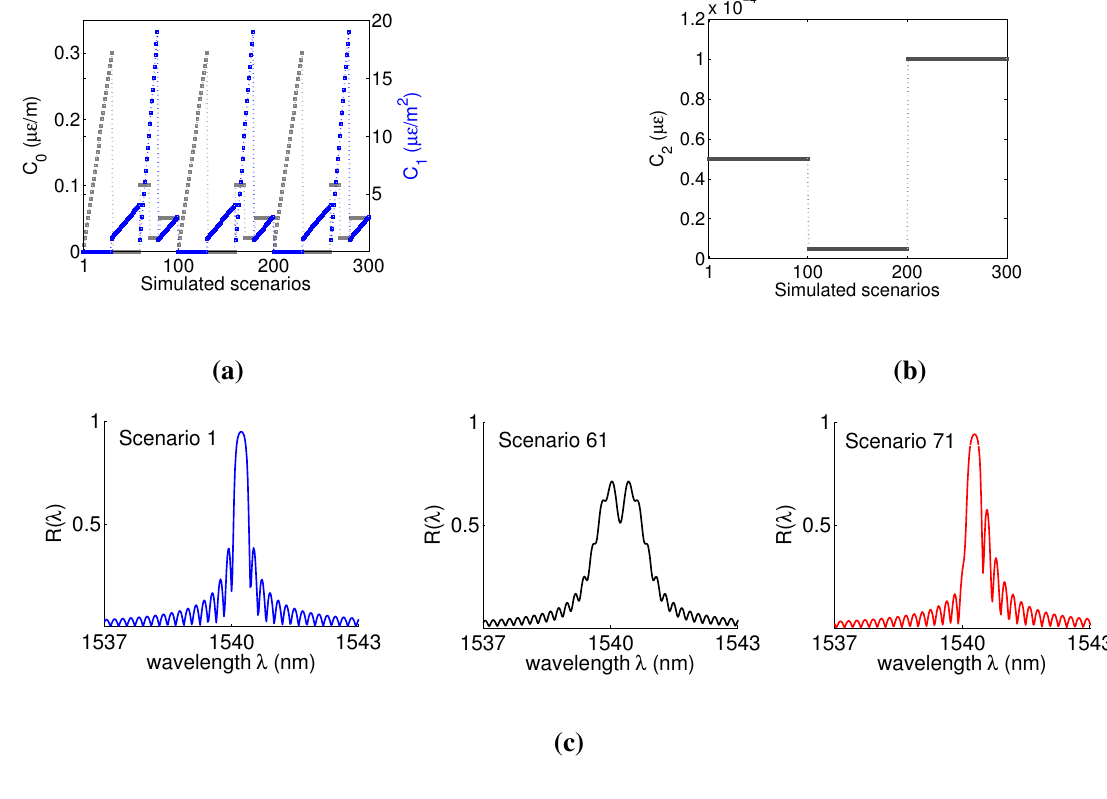
, C Figure 1. C ( a ) and C ( b ) coefficients and distorted spectra ( c ) as a function of o 1 2 the simulated scenarios. ( a ) C , C coefficients. The C o 1 0.3 µ(cid:15)/m , while C goes from zero to 19 µ(cid:15)/m 2 . Both C 1 scenarios; ( b ) C coefficient. The C coefficient varies from 5 × 10 − 5 µ(cid:15) (Scenarios 1–100) to 2 2 5 × 10 − 6 µ(cid:15) (Scenarios 101–200) and 10 − 4 µ(cid:15) (Scenarios 201–300); ( c ) Three